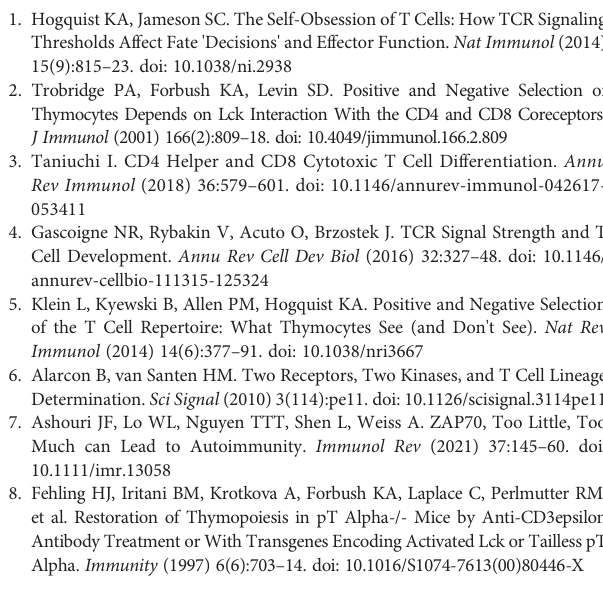
Supplementary Figure 1 | shows gating strategy for thymocytes and splenic T cells for evaluating Zap70 expression described in all the fi gures in the main text. Supplementary Figure 2 | Constitutively active Lck results in Zap70 diminution in P14-TCR transgenic mice. (A) shows CD24/TCR staining of total thymocytes and CD4/CD8 pro fi le of mature thymocytes (CD24 lo TCR + ). Bar graph shows frequency of CD4 + and CD8 + thymocytes and CD4/CD8 ratio in P14 and P14 + Lck Y505F mice. (B) shows histogram of Zap70 staining in DP, CD4 + CD8 lo , CD4 + and CD8 + thymocytes from P14 mice expressing or not Lck Y505F transgene. Number in the histogram represent MFI for Zap70 staining. Bar graph shows compilation of Zap70 MFI for the indicated thymic subset normalized to CD8 SP thymocytes from P14 control mice in each experiment. (C) TCR and CD4/CD8 staining and frequency of splenic T cells. Zap70 staining of CD4 and CD8 T cells from P14 mice expressing or not Lck Y505F is shown. Bar graph shows compilation of Zap70 MFI in the indicated T cell subsets from P14 and P14 + Lck Y505F mice normalized to that in CD8 T cells from P14 mice in each experiment. Data are representative example of 3 or more independent experiments (n > 6 mice). Supplementary Figure 3 | Constitutive Thpok-H expression does not alter Zap70 expression. (A) Staining of thymocyte for the indicated surface markers from OTI and OTI + Th-H + mice is shown. Zap70 staining histograms for DP, CD4 + 8 lo , CD4 + and CD8 + thymocytes are shown. (B) shows TCR and CD4/ CD8 staining of splenic T cells and shows analysis of Zap70 expression in CD4 and CD8 T cells from OTI and OTI + Th-H + mice. Number in the histogram indicated Zap70 MFI (n>3 mice in three independent